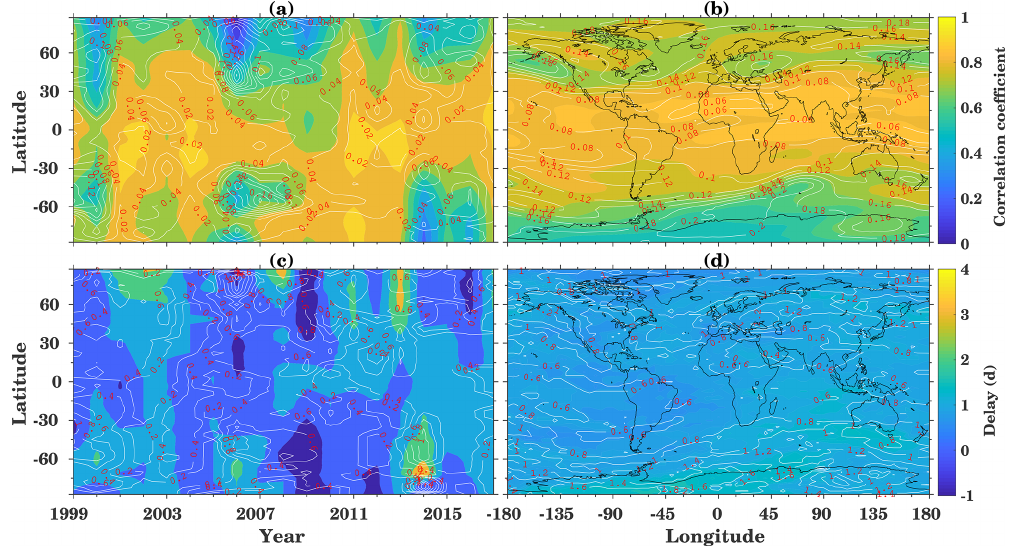
Figure 10. (a, c) Zonal mean and (b, d) long-term mean correlation coefficients (a, b) and time delay (c, d) between TEC and Mg II index for the years 1999 to 2017. The white contour lines indicate the respective standard